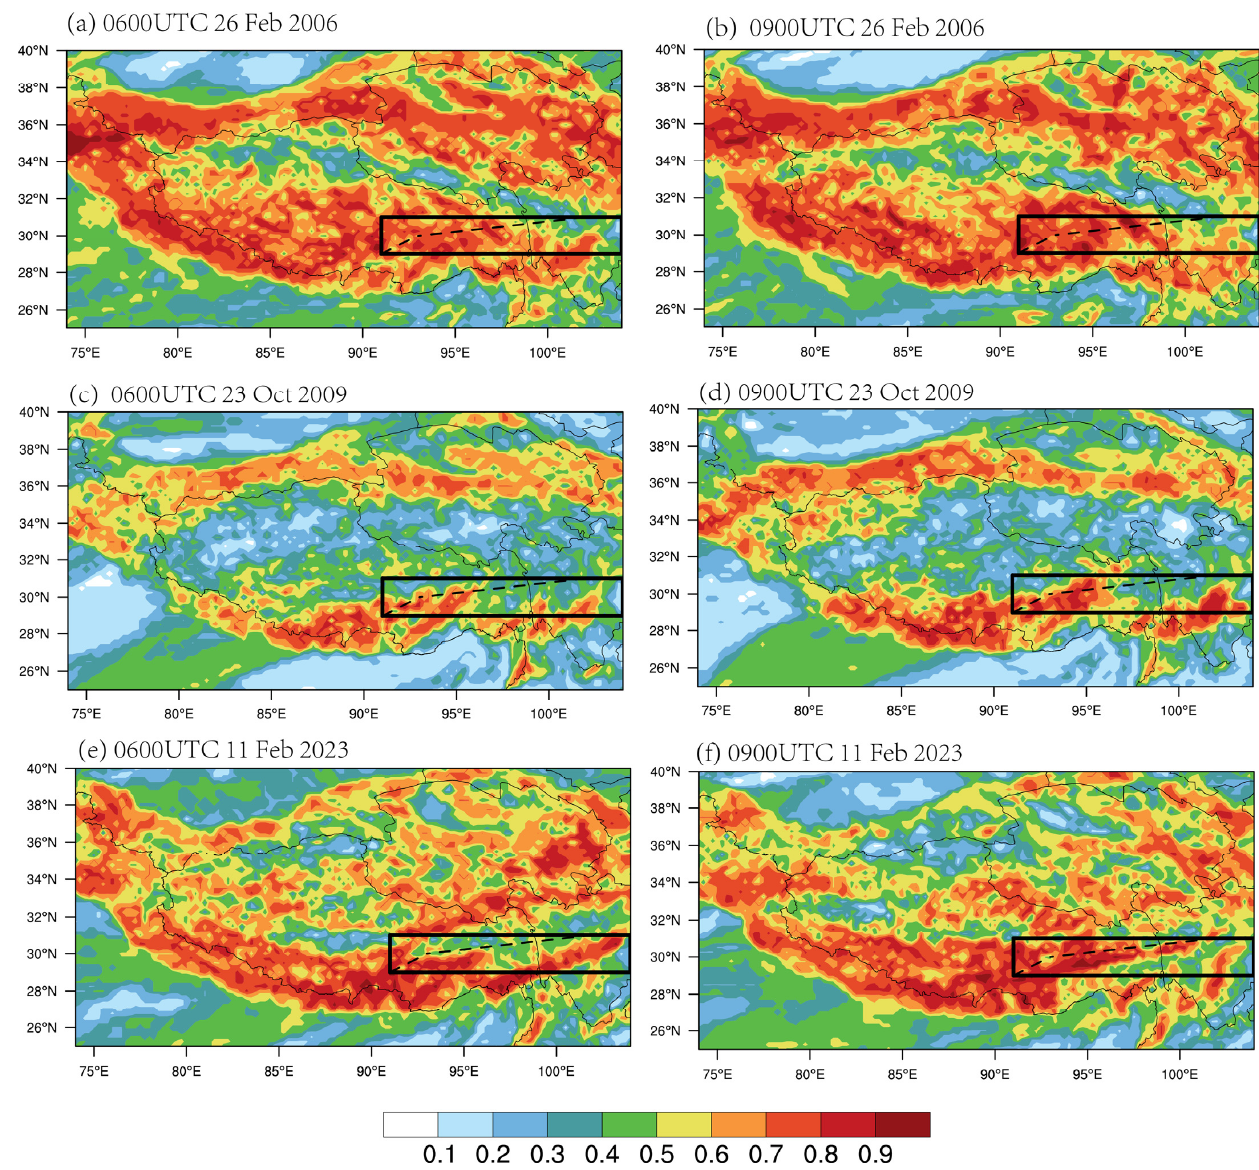
Figure 3. PI for light or greater turbulence at 200 hPa at ( a ) 0600 UTC 26 February 2006, ( b ) 0900 UTC 26 February 2006, ( c ) 0600 UTC 13 October 2009, ( d ) 0900 UTC 13 October 2009, ( e ) 0600 UTC 11 February 2023, and ( f ) 0900 UTC 11 February 2023. The black squares represent the range of the Chengdu–Lhasa route.